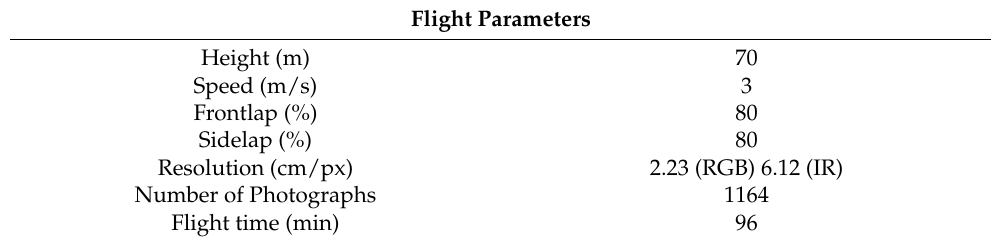
Table 3. Flight plan parameters.